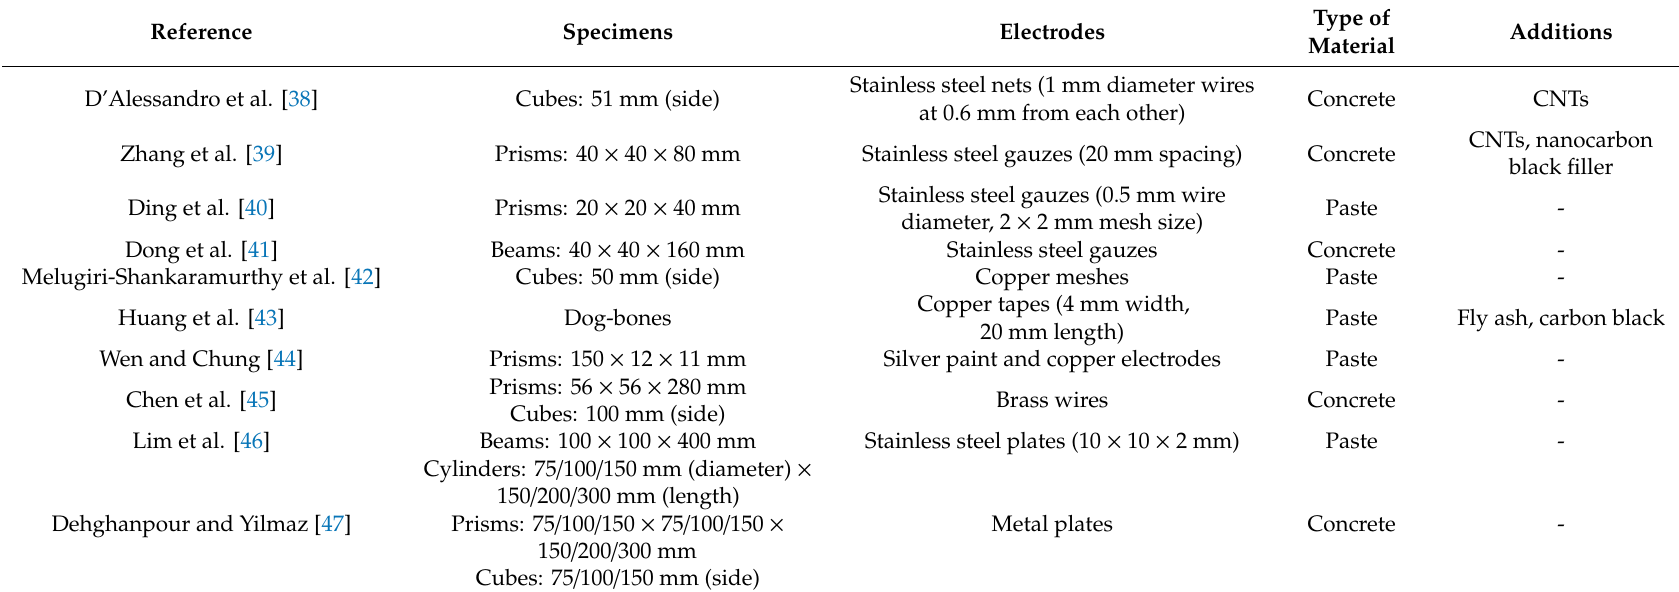
Table 1. DC measurements with 2-point probe